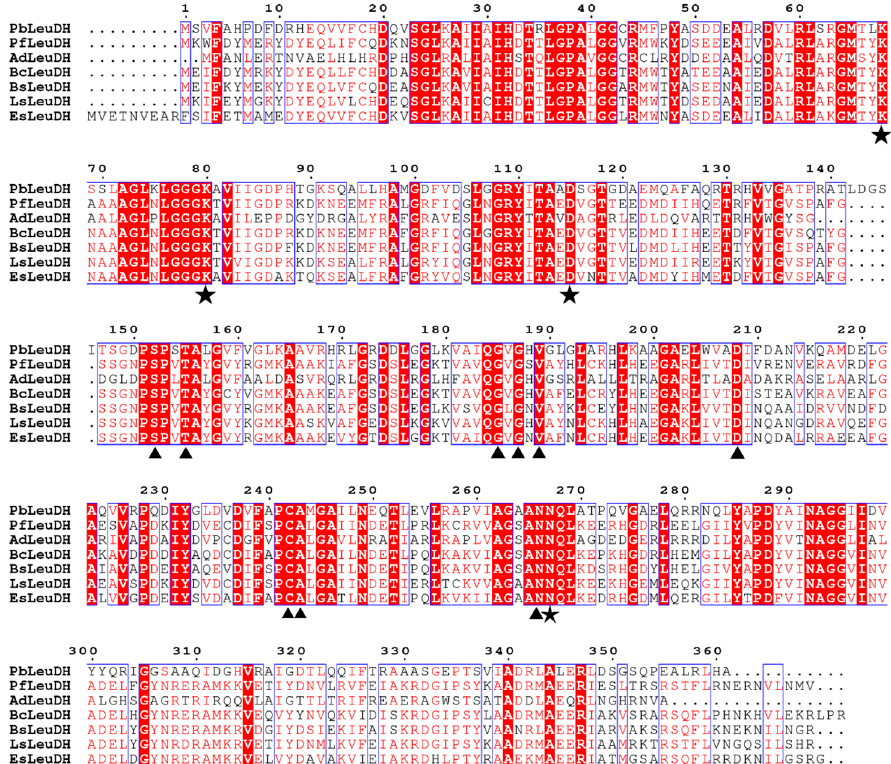
Figure 2. Multi-sequence alignment analysis of Pb LeuDH with other reported LeuDHs from different strains. The sequences compared include Pb LeuDH from P. balearica , Pf LeuDH (GenBank ID: WP_106345646.1) from P. fimeticola , Ad LeuDH from A. dieselolei MCCC 1A02288, Bc LeuDH (GenBank ID: WP_017550506.1) from B. coagulans NL01, Bs LeuDH from B. sphaericus ATCC 4525, Ls LeuDH (GenBank ID: WP_022736188) from L. sacchari , and Es LeuDH from E. sibiricum ECU9271. The residues of the active site and NAD(H) binding site are highlighted with the symbol star ( (cid:70) ) and triangle ( (cid:78) ),